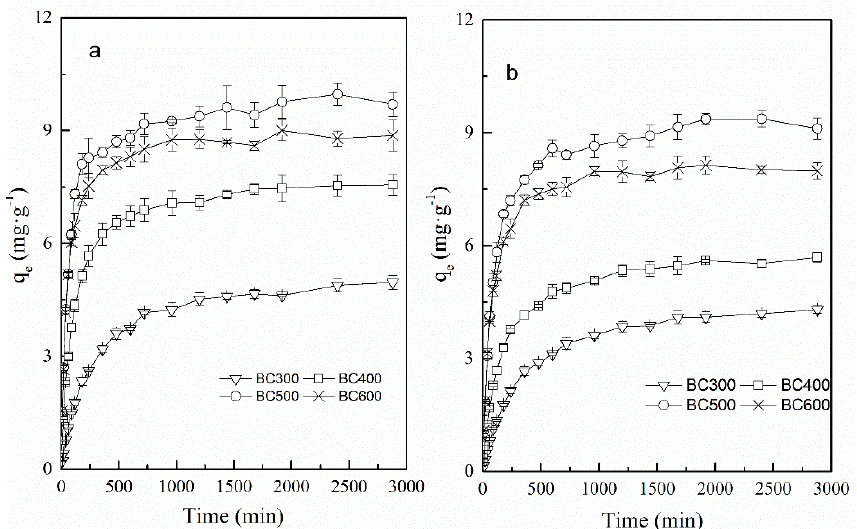
Figure 5. Effect of contact time on Cu(II) ( a ) and Zn(II) ( b ) adsorption by BCs produced at different temperatures (initial Cu(II) concentration 64 mg L −1 , initial Zn(II) concentration 65 mg L −1 ; reaction temperature 25 °C; BC dosage 5 g·L −1 ; initial solution pH 5.0). Error bars represent standard error ( n =